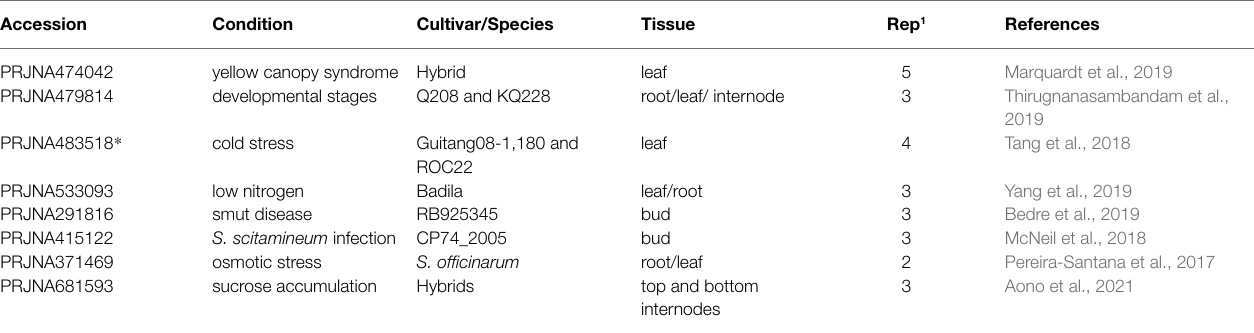
TABLE 1 | RNA-Seq experiments performed for sugarcane gene expression